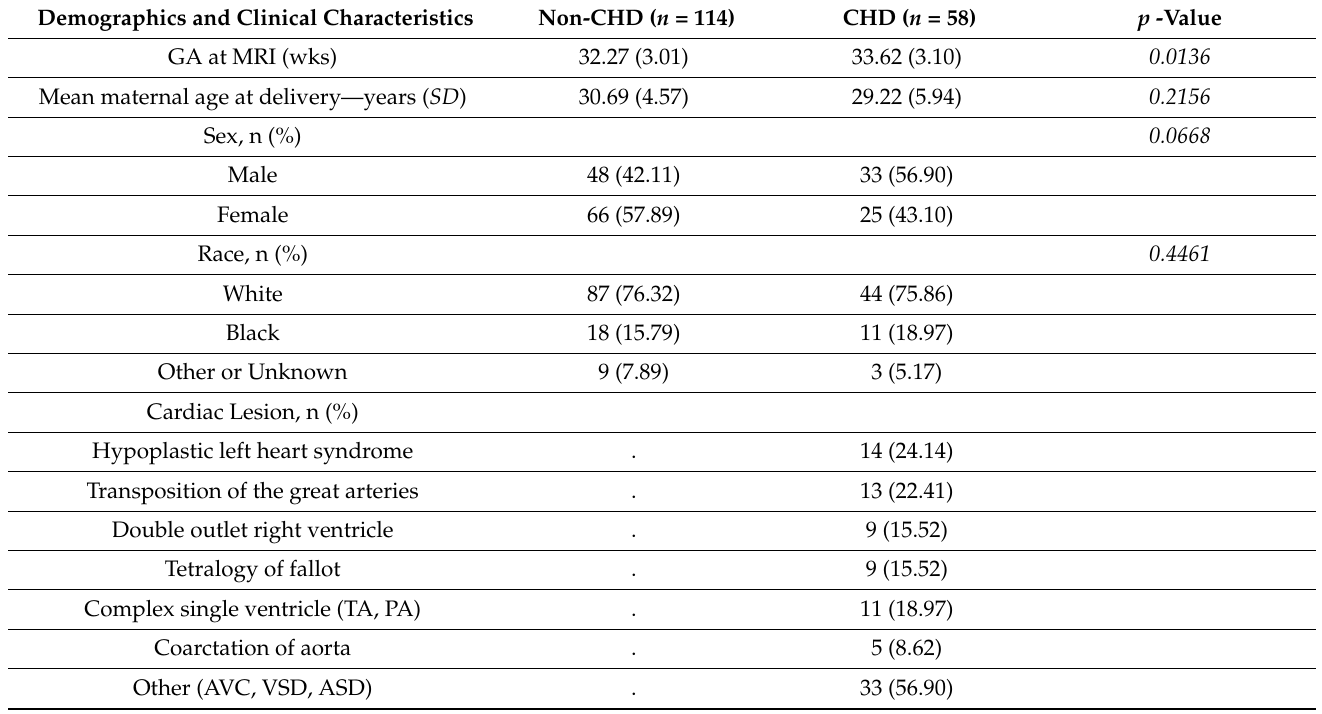
Table 1. Demographic and Clinical Characteristics of CHD and Non-CHDs